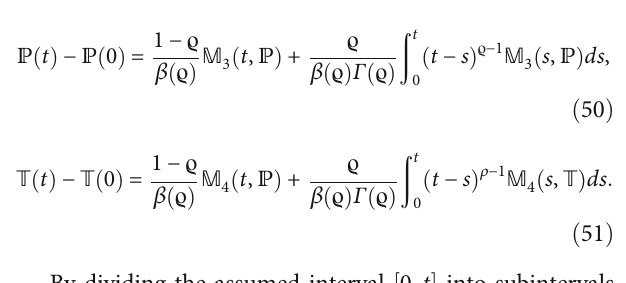
Figure 4: The joint solution for ϱ = 0 : 94